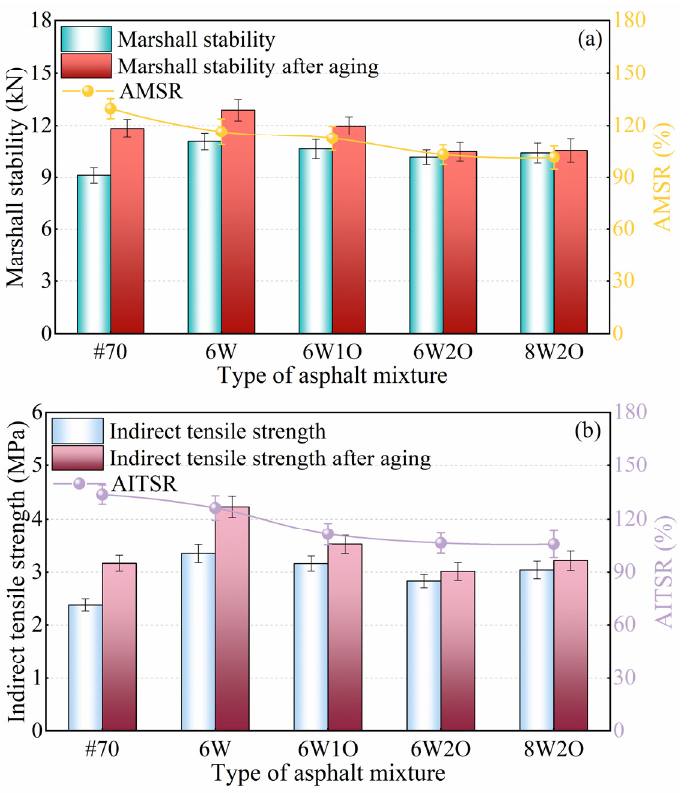
Figure 12. Test results of anti-aging performance. (a) Test results of Marshall stability and AMSR after aging. (b) Test results of indirect tensile strength and AITSR after aging.